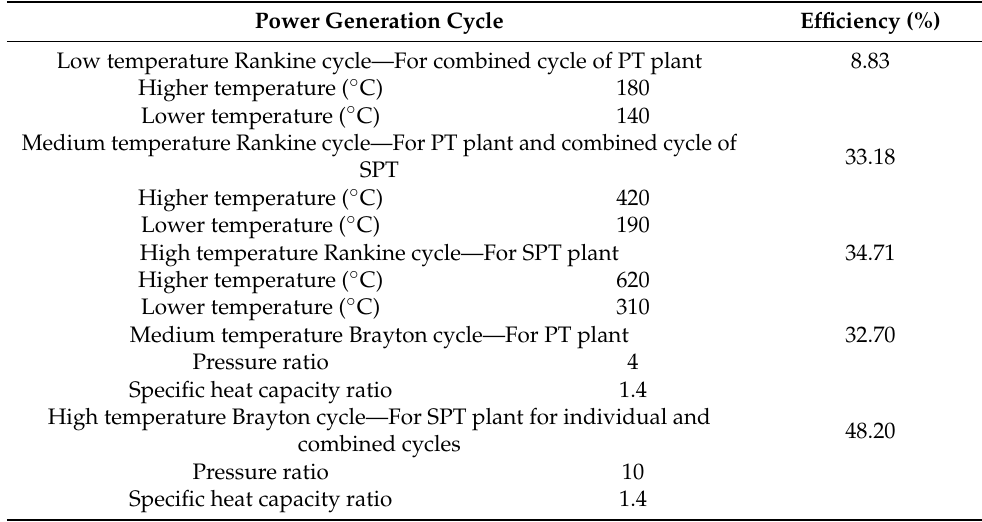
Table 10. Operational parameters for Rankine, Brayton, and combined cycles. Power Generation Cycle Efficiency (%)